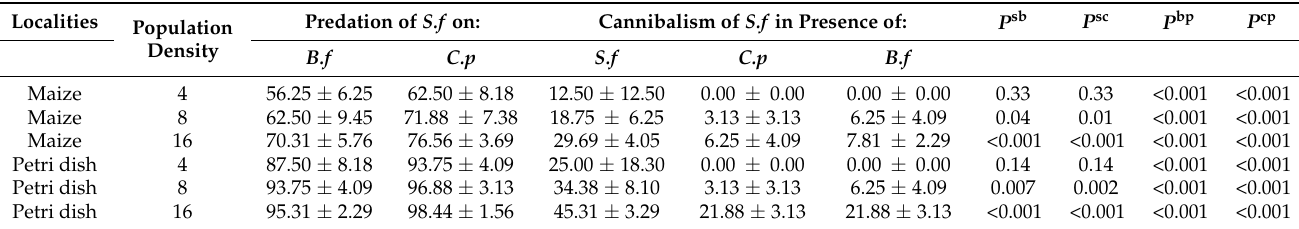
Table 3. Percentage predation and cannibalism of Spodoptera frugiperda on Busseola fusca, Chilo partellus , and conspecifics on maize plant and maize leaf in a Petri dish.